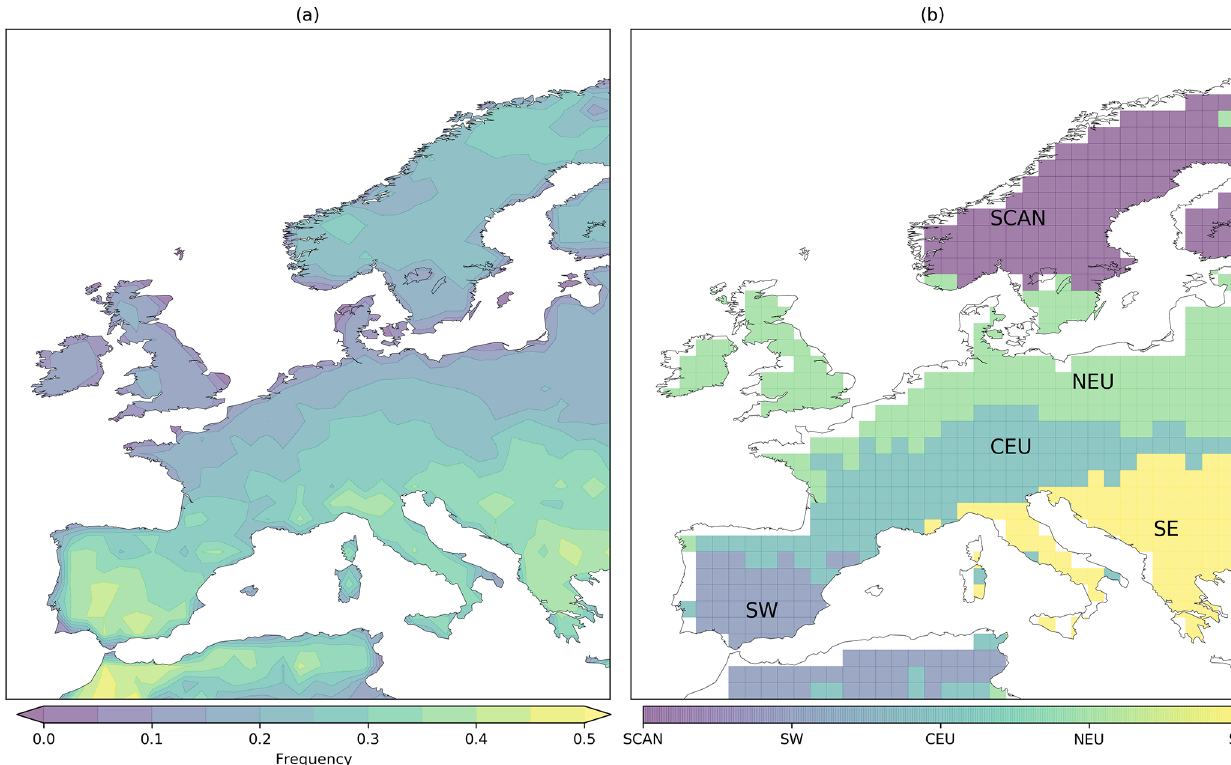
Figure 1. (a) The annual of frequency of air stagnation in Europe between 1979 and 2018 in the ERA5 dataset. (b) Regions within Europe identified as having distinct air stagnation characteristics. These regions have been named Scandinavia (SCAN), northern Europe (NEU), central Europe (CEU), southwest Europe (SW) and southeast Europe (SE), following Garrido-Perez et al.